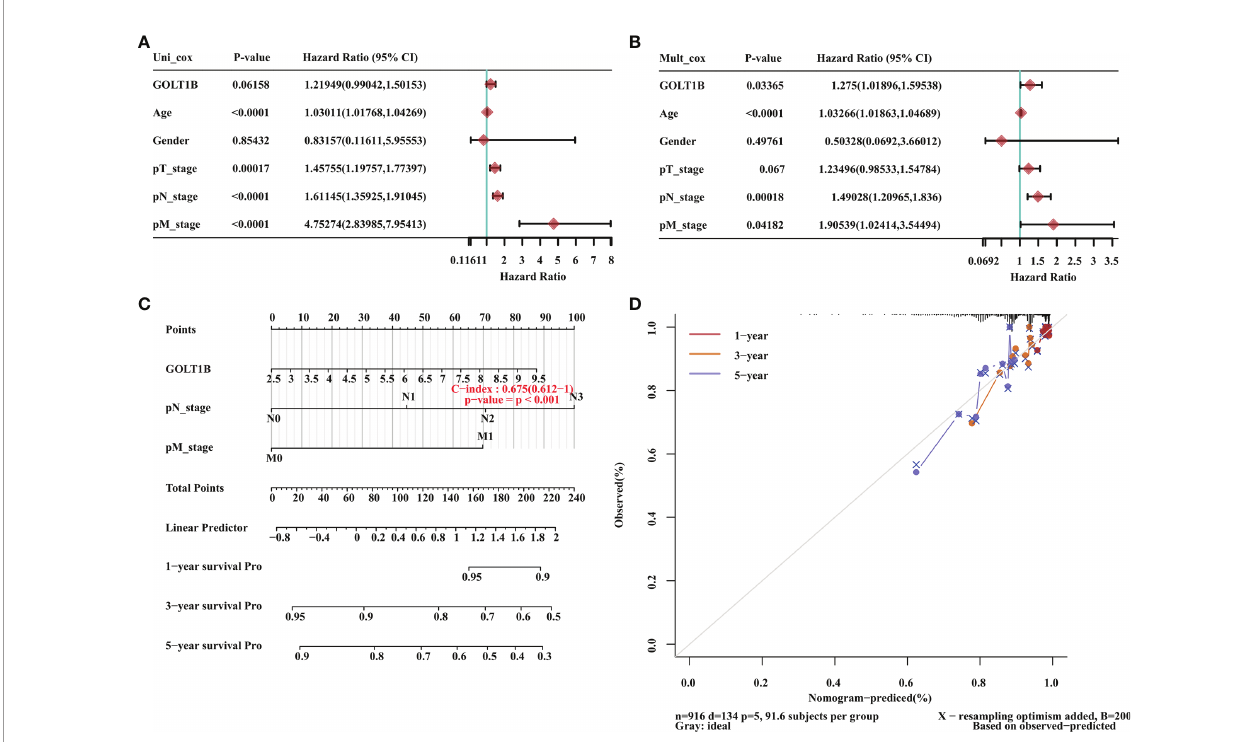
FIGURE 3 | GOLT1B is one potential independent prognostic gene for breast cancer. (A) Univariate Cox analysis revealed that GOLT1B was associated with the risk of breast cancer. (B) Multivariate Cox analysis identi fi ed GOLT1B as a potential independent prognostic gene of breast cancer. (C, D) The nomogram showing the function of GOLT1B in the scoring of prognostic risks of breast